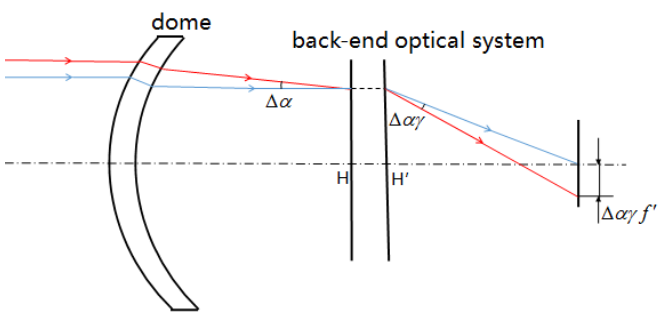
Figure 4. Schematic diagram of the equivalent optical system of an airborne optical system.